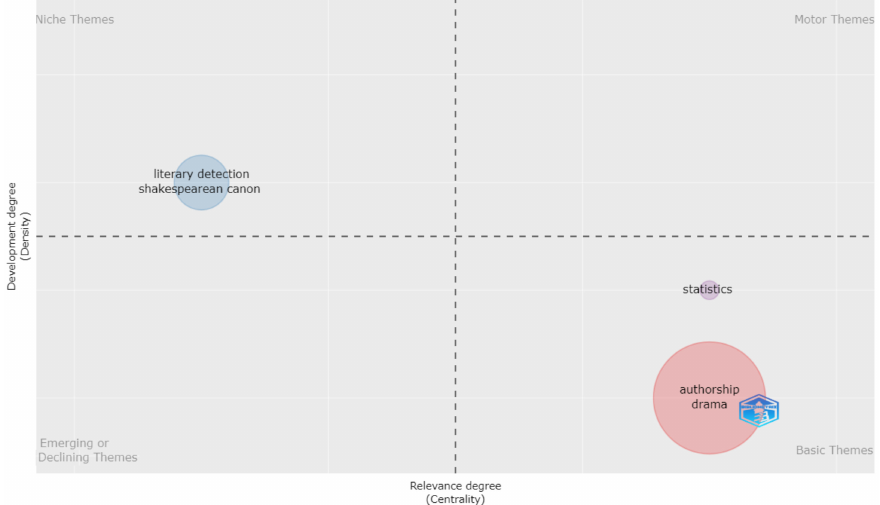
Figure 10. Thematic map for Period 1 (1968–1991) (this map was generated by Biblioshiny).